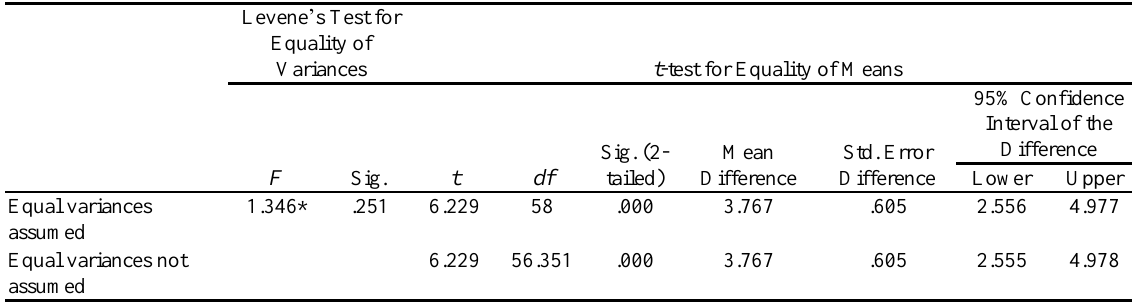
Table 3 Independent samples t -test, delayed post-test by groups Levene’s Test for Equality